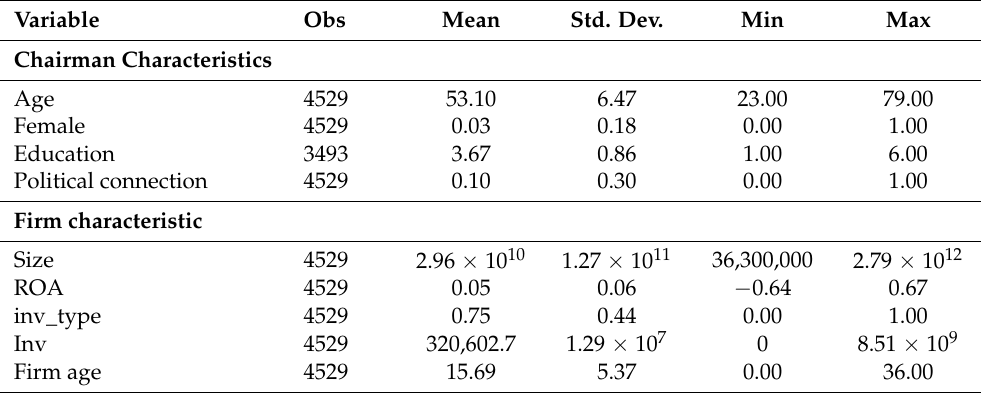
Table 4. Descriptive statistics for the regression